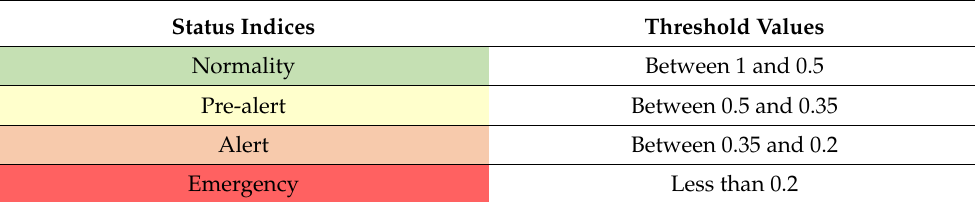
Table 5. Status indices and threshold values. Source: SDP 2007 [51].